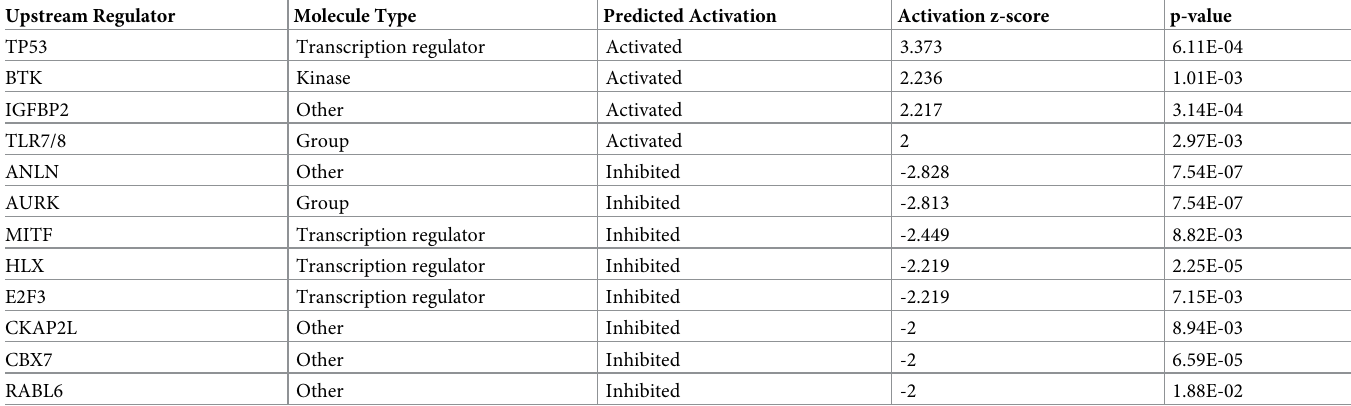
Table 4. The upstream regulators predicted by IPA are based on the DEGs in MOL-treated hWJMSCs. Upstream Regulator